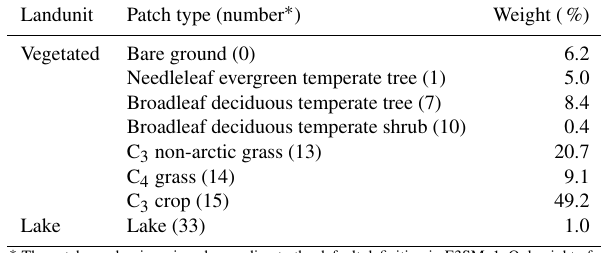
Table 1. Subgrid patches and their respective weights relative to the model grid cell over the ARM SGP